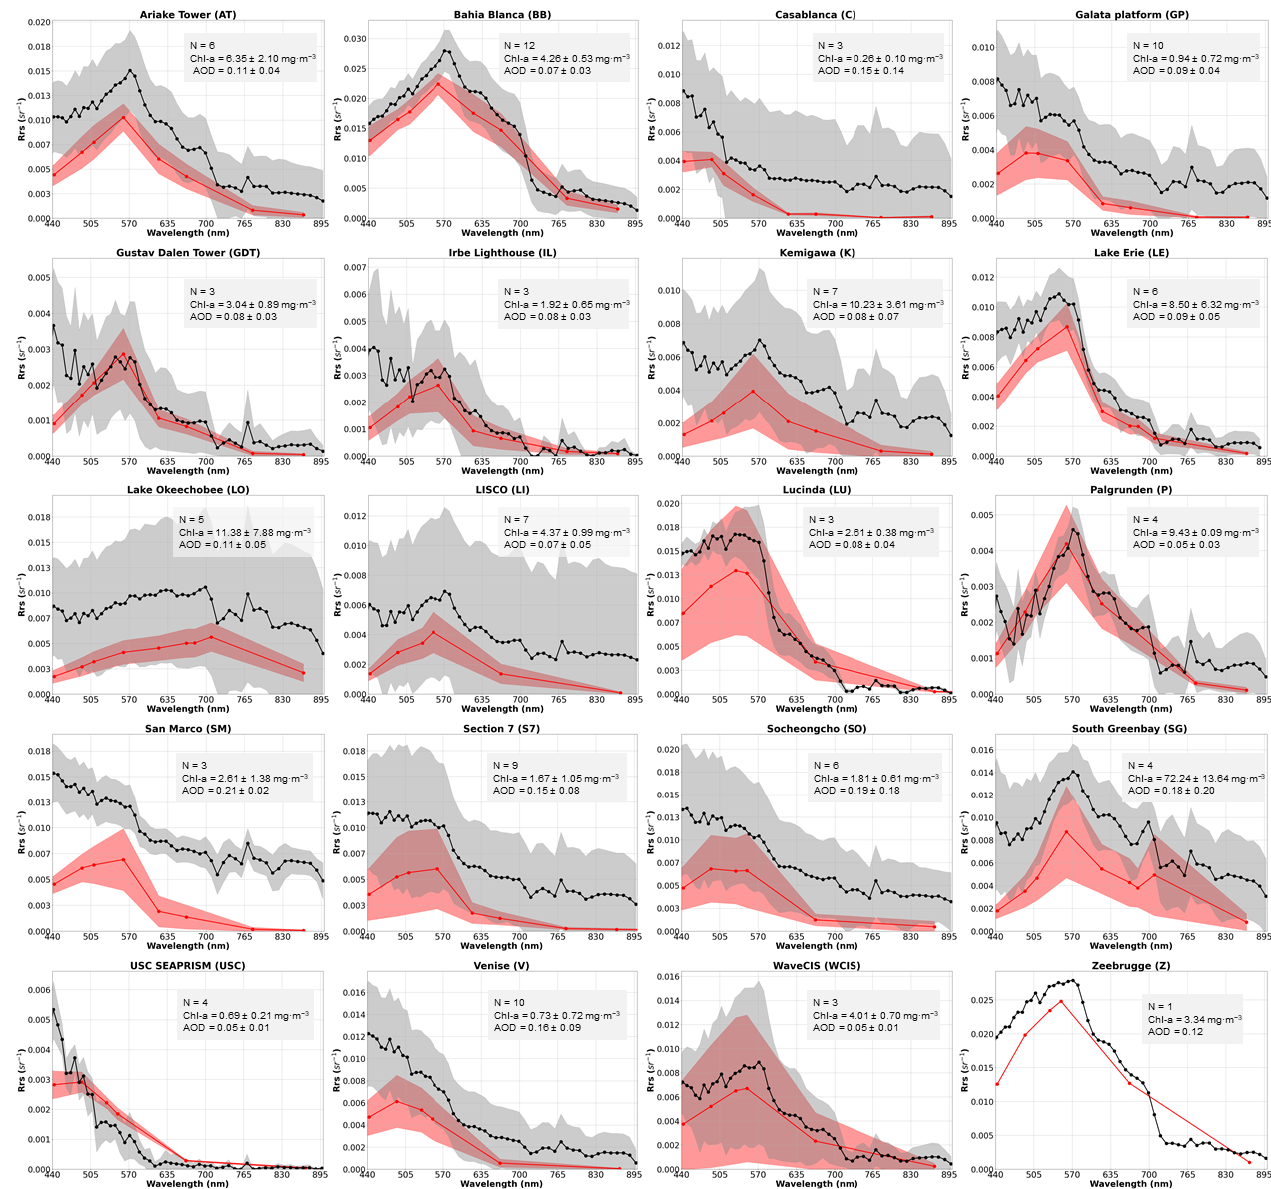
Figure 3. Comparisons of mean PRISMA L2d and AERONET-OC Rrs data. The variability in the mean spectra of PRISMA L2d is displayed in dark curves with the shaded grey area representing one standard deviation. The mean and standard deviation of AERONET-OC are equivalently shown in red.